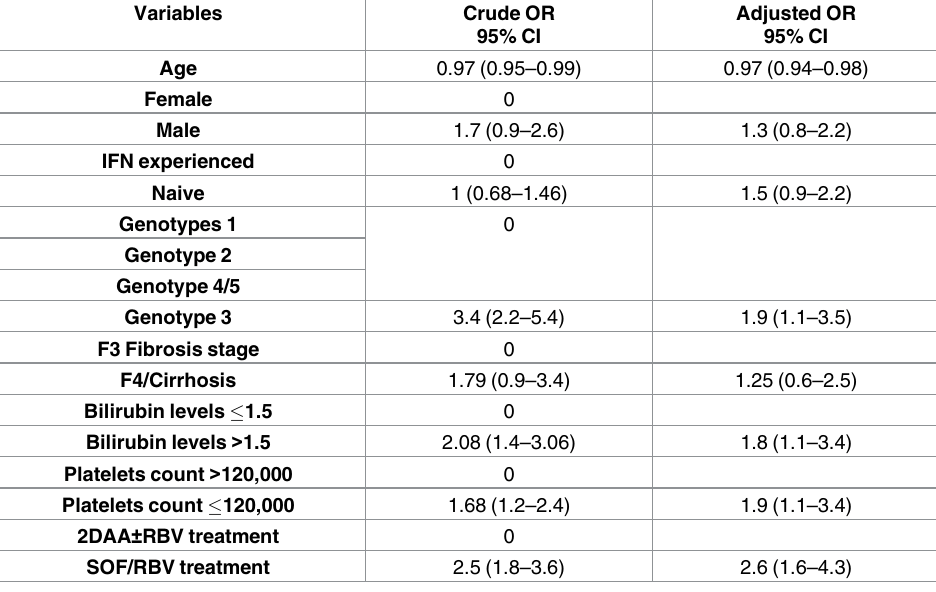
Table 2. Univariate and logistic regression analysis linking failure with independent